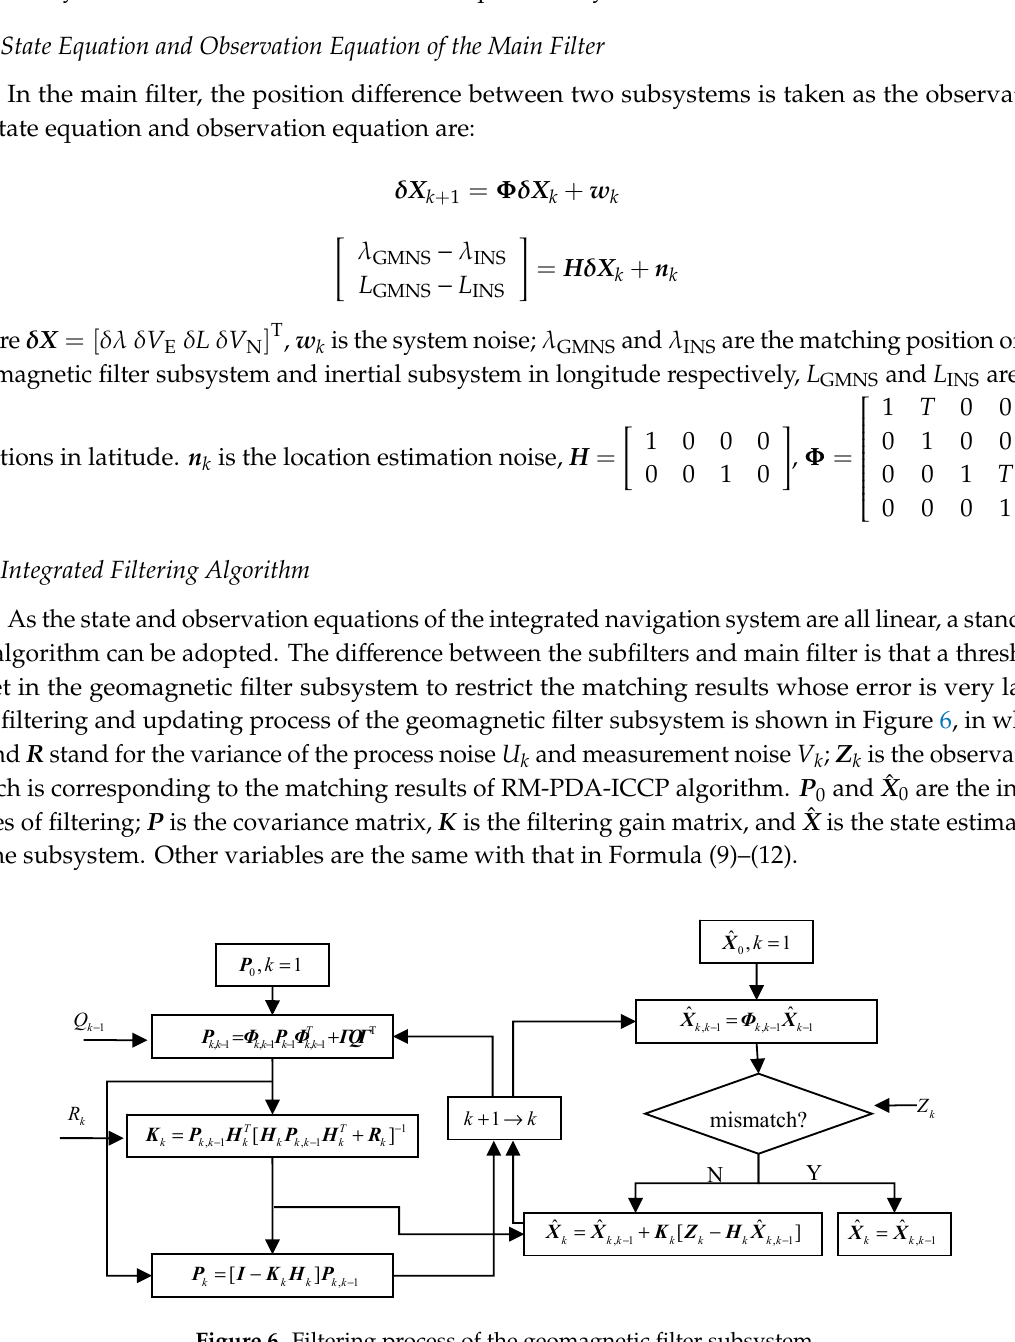
Figure 6. Filtering process of the geomagnetic filter subsystem.